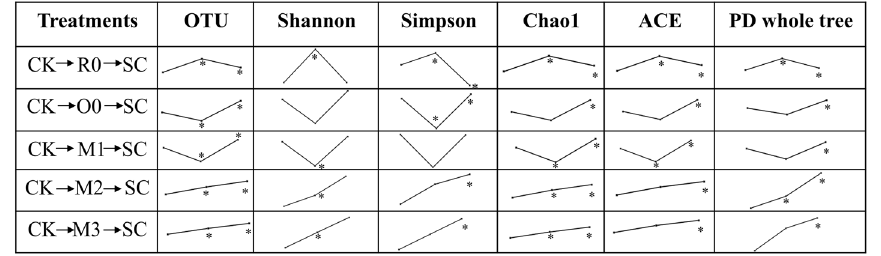
Figure 2. The change tendency in soil bacteria α-diversity indices in the ARMR system, with three replicates for each data. The same below. The asterisks indicated the significant differences of soil bacteria α-diversity indices between preceding crop/successive crop and CK with the level of P =